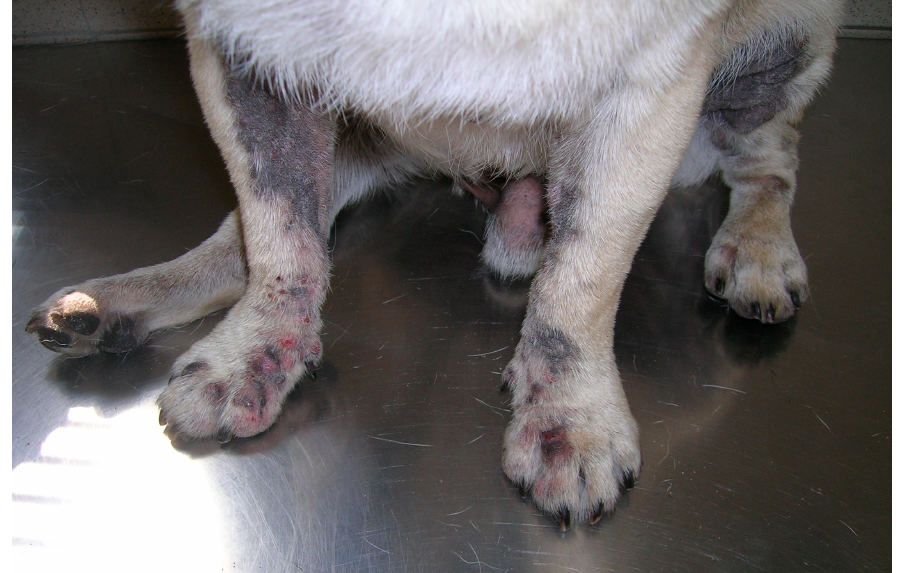
Figure 1. Hyperpigmented inflammatory lesions in a dog with Malassezia dermatitis secondary to a Demodex mites infestation.